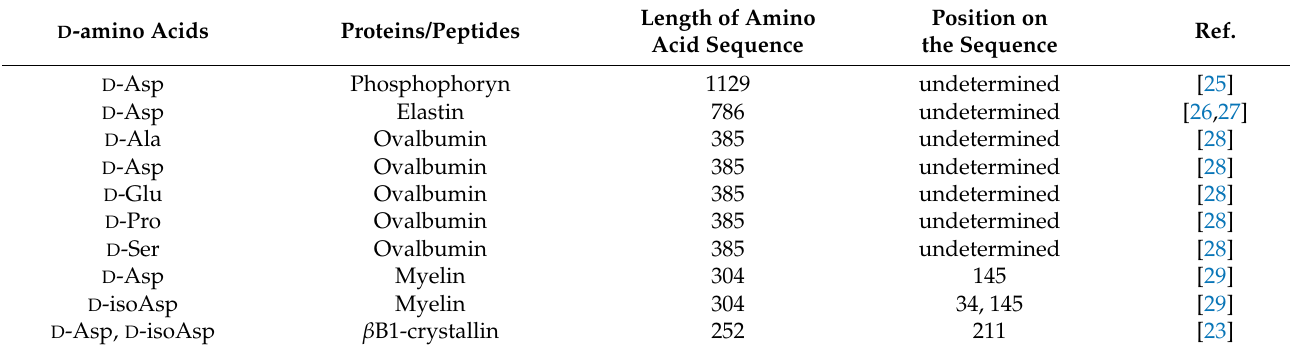
Table 1. Position of D -amino acids in protein/peptide